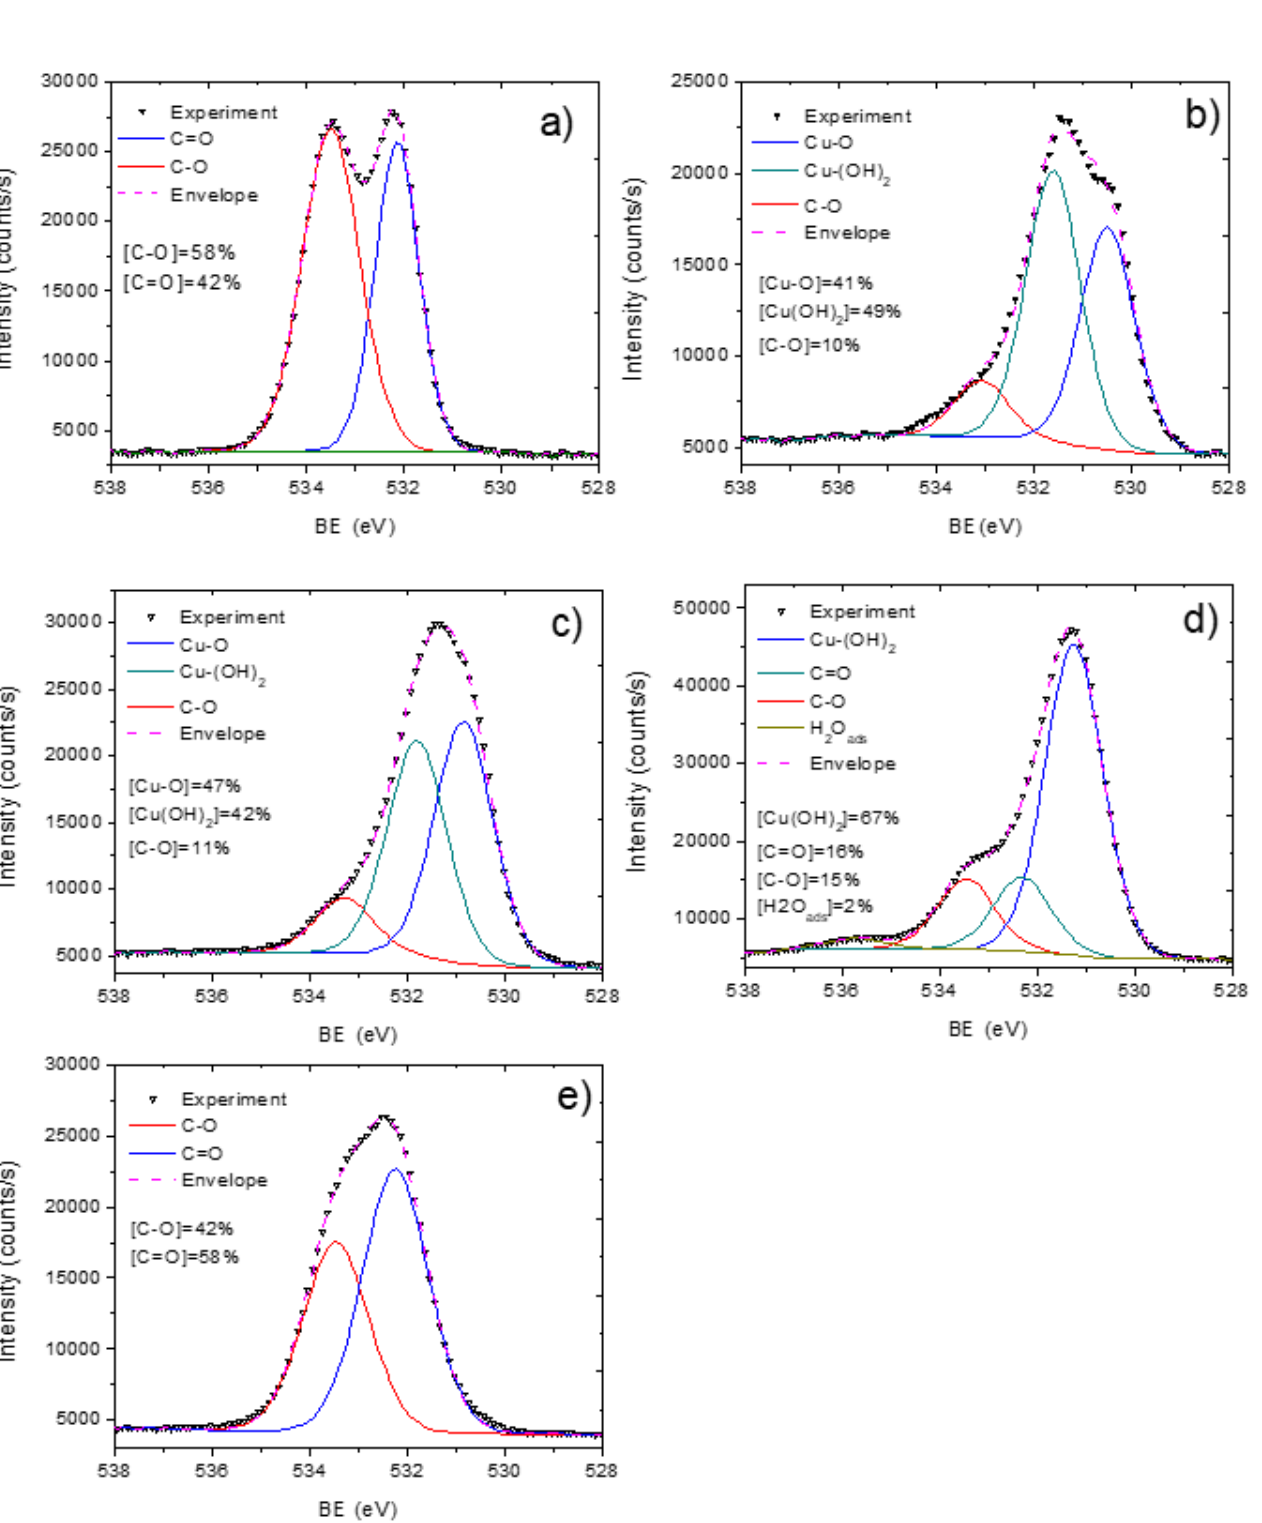
Figure 8. XPS O1s curve fitting of pristine PCL nanofibers PCL-ref ( a ), PCL-Cu as-deposited ( b ), PCL-Cu after two hours in PBS ( c ), PCL-Cu after 24 h in PBS ( d ), and PCL-Cu-COOH ( e ).